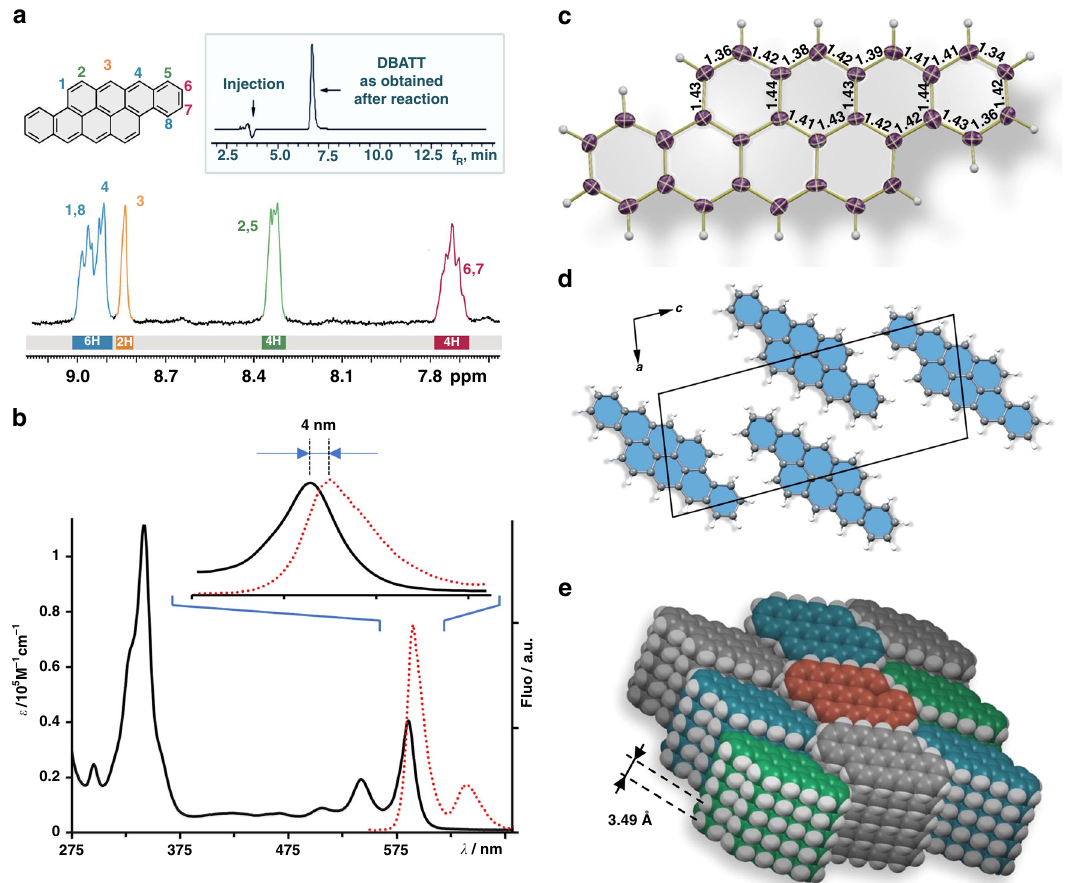
Fig. 4 Spectroscopic analysis and structure elucidation of DBATT . a 1 H NMR ( o- DCB-D 4 , 100 °C, 400 MHz); proton assignments were correlated with computed NMR spectra at the DFT RB3LYP 6 – 311 + G(d, p) GIAO level of theory; inset shows HPLC chromatogram after reaction work-up; b absorption (black) and emission (red) in THF at rt; c single crystal X-ray structure depicted as ORTEP model with 50% thermal ellipsoids, independent C – C bond lengths are indicated; d View onto the (101) face of the crystal (lattice) structure; depicted as balls and sticks model; e columnar crystal packing motif of DBATT with an interlayer distance of 3.49 Å; depicted as space fi lling